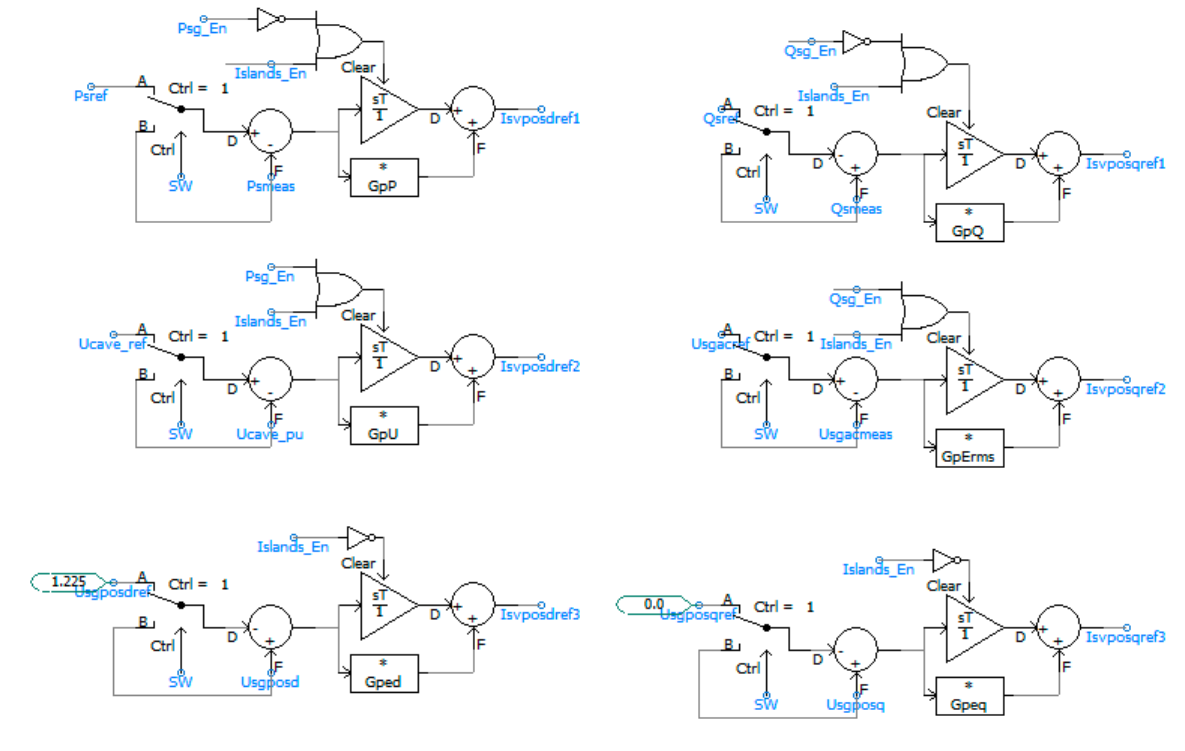
Figure A2. Simulation model of M3C outer loop controller.